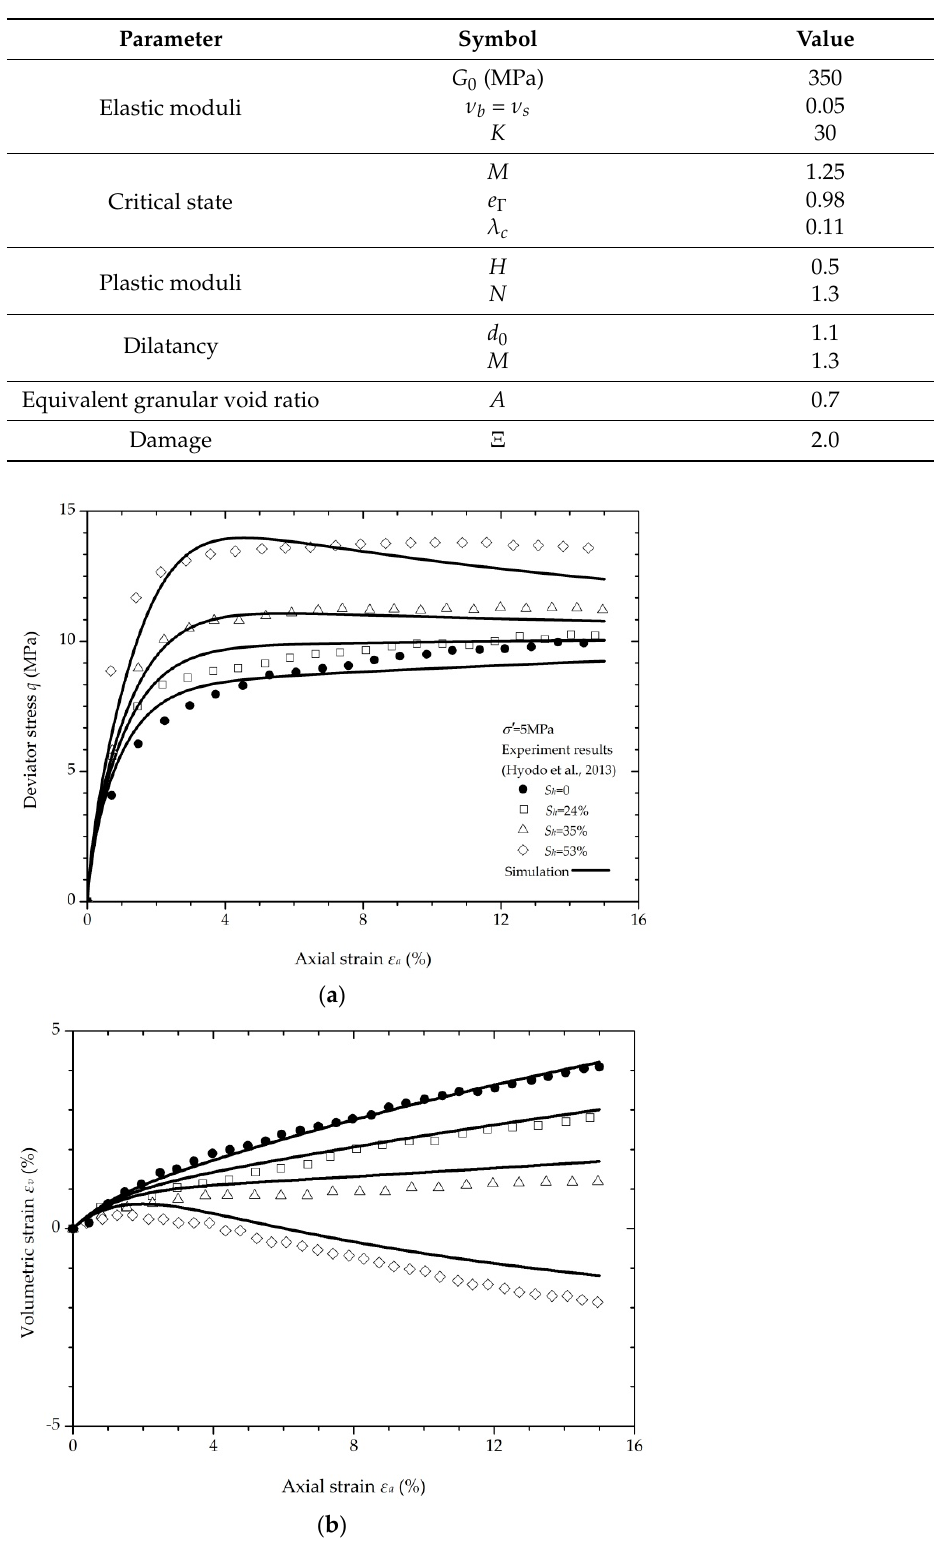
Table 1. Parameters for methane hydrate bearing sand (MHBS) synthesized from Toyoura sand.